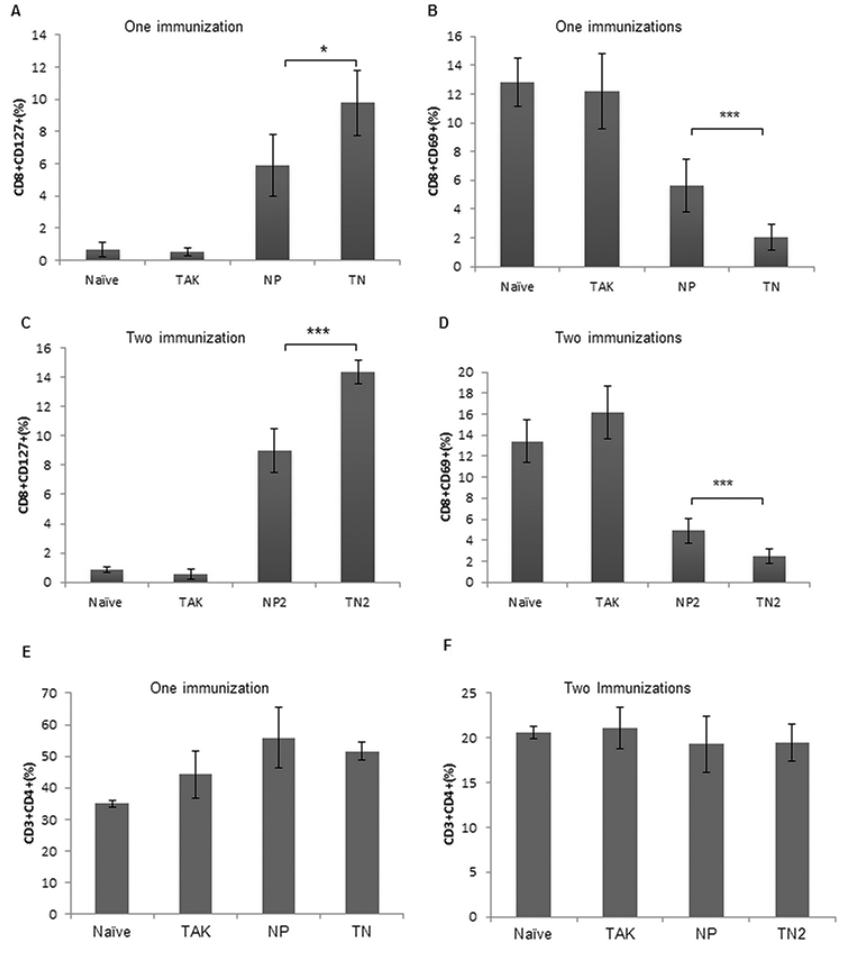
Figure 4. Staining of CD127 and CD69 on CD8 cells and detection of CD4 + cells from NP immunized mice with or without TAK-779 treatment. Two weeks after TAK-779 cessation, splenocytes were prepared from different mice groups and analyzed by flow cytometry after staining with anti-Mouse CD8a-APC, anti-Mouse CD127-FITC, anti-Mouse CD69-PE, anti-Mouse CD3e-PE-cy TM 7, anti-Mouse CD4-FITC or isotype control antibodies. Percent- age of CD8 + CD127 + (A and C) and CD8 + CD69 + (B and D) cells in mice immunized once (A and B) or twice (C and D) with NP with or without TAK-779 treatment were analyzed by flow cytometry and compared with mice from the control group. Percent- age of CD3 + CD4 + cells immunized once or twice with NP is illustrated in (E) and (F), respectively. NP: 1 NP immunization; NP2: 2 NP immunizations; TN: 1 NP immunization with TAK-779 treatment; TN2: 2 NP immunizations with TAK-779 treatment. Results are expressed as the mean ± SD. * p ≤ 0.05; *** p ≤ 0.001. The data are representative of 2 independent experiments with at least 4 mice per group. Mice were analyzed